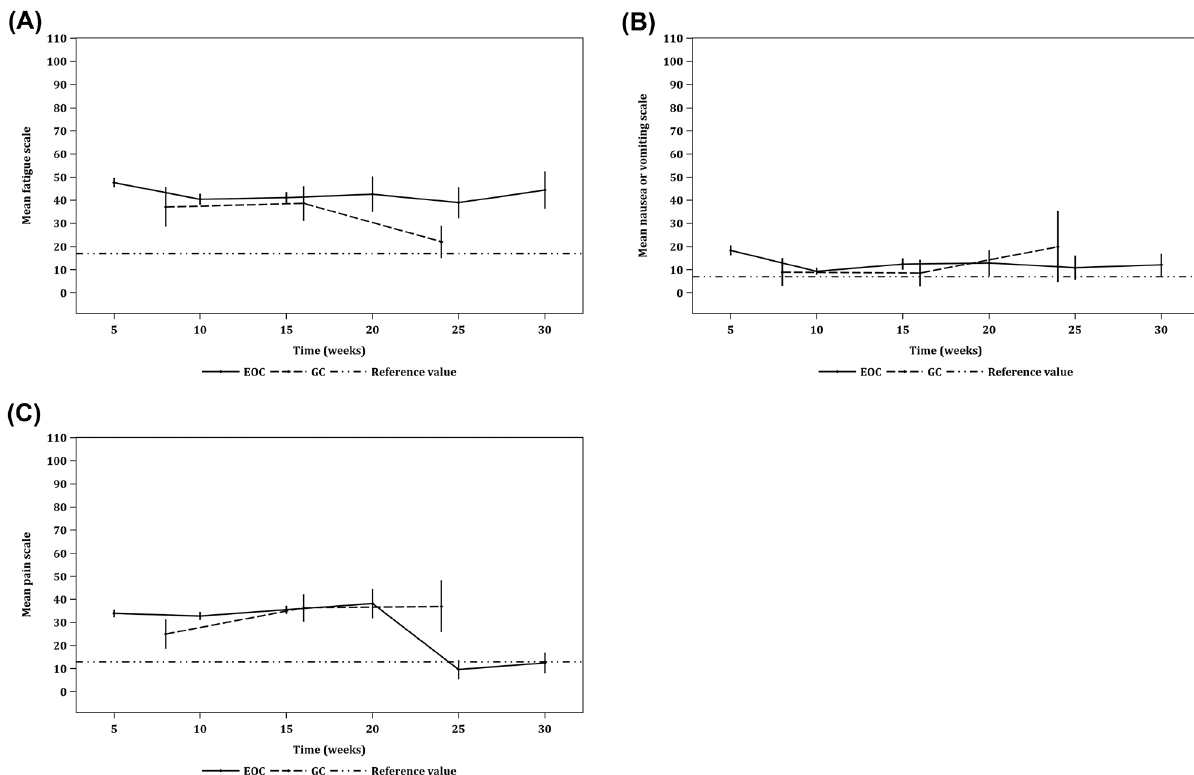
Figure 4: Line graphs depicting the three multiple-itemed symptom scales of QoL as measured by EORTC QLQ-C30 across time. Line graphs of (A) fatigue, (B) nausea and vomiting, and (C) pain. Each three-point trendline depicts its respective multiple-itemed symptom scores before the fi rst, second, and third cycles of PIPAC (c) in patients with PM from gastric cancer (GC); c1=31, c2=22, c3=5. Each six-point trendline depicts its respective multiple-itemed symptom scores before the fi rst, second, third, fourth, fi fth, and sixth cycles of PIPAC in patients with PM from epithelial ovarian cancer (EOC); c1=104, c2=70, c3=50, c4=9, c5=6, c6=4. Error bars represent 95% CIs. Signi fi cant deterioration was found in the fatigue scale (FA) within GC and in the nausea and vomitingscale (NV) within EOC. As a reference, each dashed linerepresentsasnapshotofitsrespectivemultiple-itemedsymptomscorein6 – 18monthsafterCRS/HIPECinacohortofpatients(n=27)with PM from a mixed histological